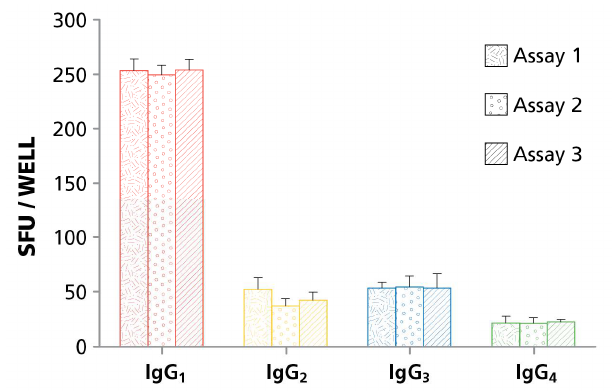
Figure 3. Reproducibility of the four color B cell assay. To assess inter-assay variation in spot numbers, PBMC were stimulated polyclonally, and frozen in aliquots on day four. Three independent assays were performed after thawing an aliquot, measuring the four IgG subclasses on anti-κ/λ capture antibody-coated membranes. Each bar represents the mean spot count + SD for the tests done in four replicate wells.